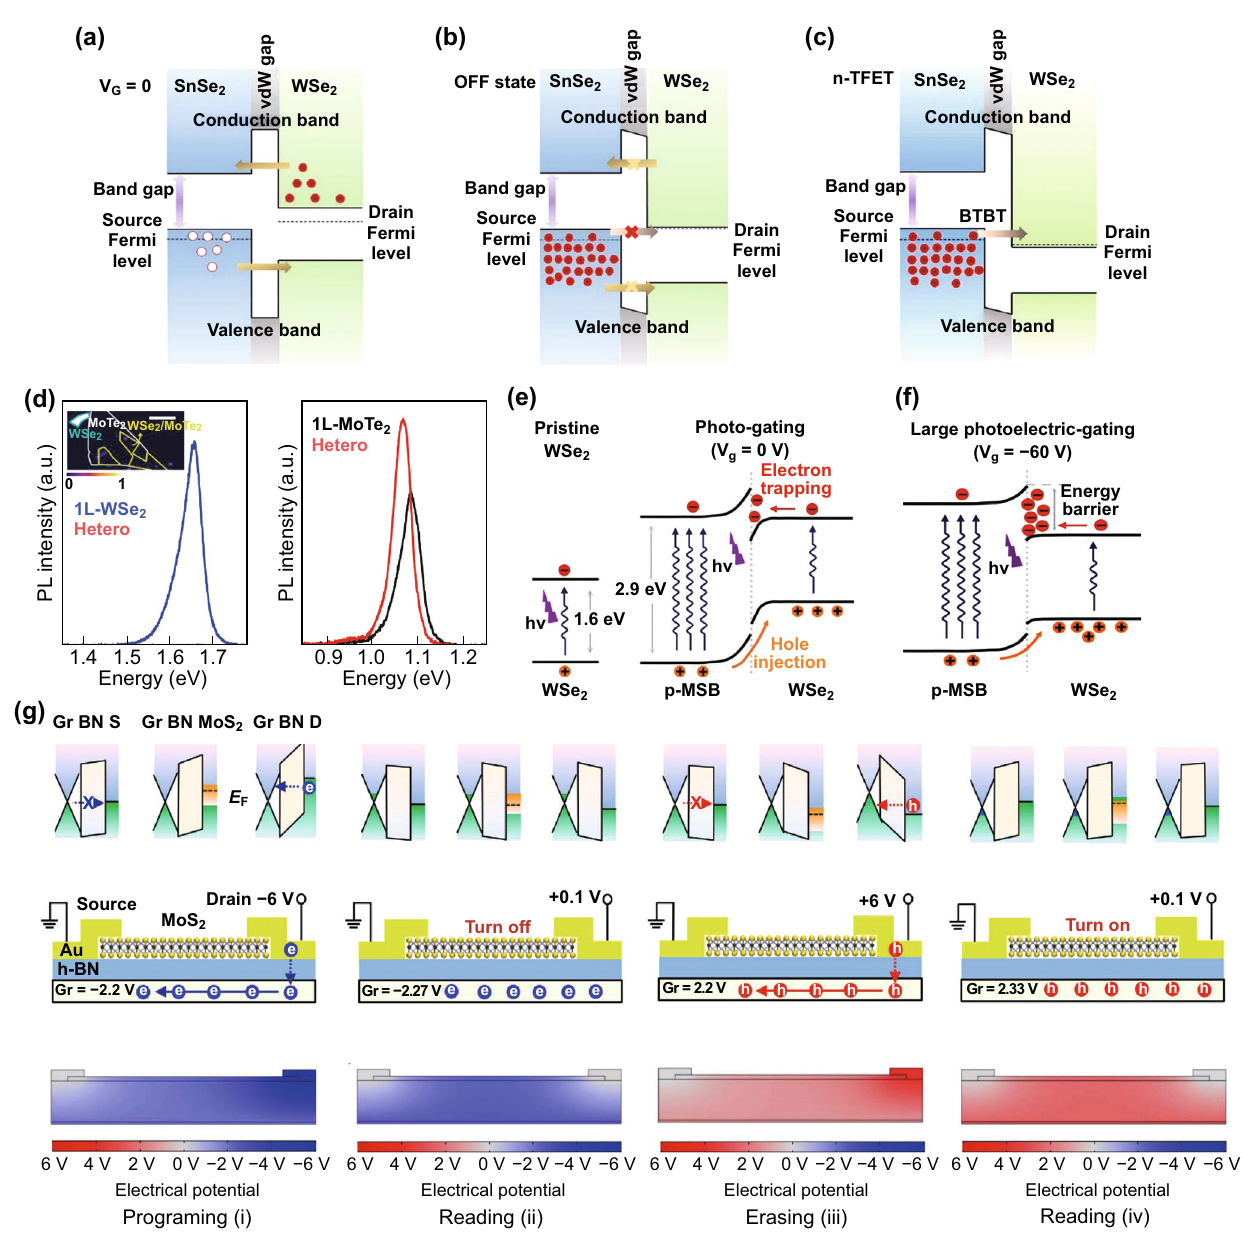
Fig. 4 The single‑particle transport caused by different band structures. a – c The electronic modulation of BTBT in a TFET based on 2D SnSe 2 / WSe 2 heterostructure. Reprinted with permission from Ref. [52]. d PL measurement of a stacked WSe 2 /MoTe 2 heterostructure with proper annealing, where the blue, black, and red lines correspond to the PL intensity of specific energy (eV) from the isolated WSe 2 region, isolated MoTe 2 region, and hetero‑stacked region, respectively. Reprinted with permission from Ref. [53]. e , f The diagram of the charge transferring in p‑MSB/WSe 2 heterostructure under illumination. Reprinted with permission from Ref. [54]. g The band alignment, charge transportation, and the distribution of the potential in the device. Reprinted with permission from Ref. [39]. (Color figure